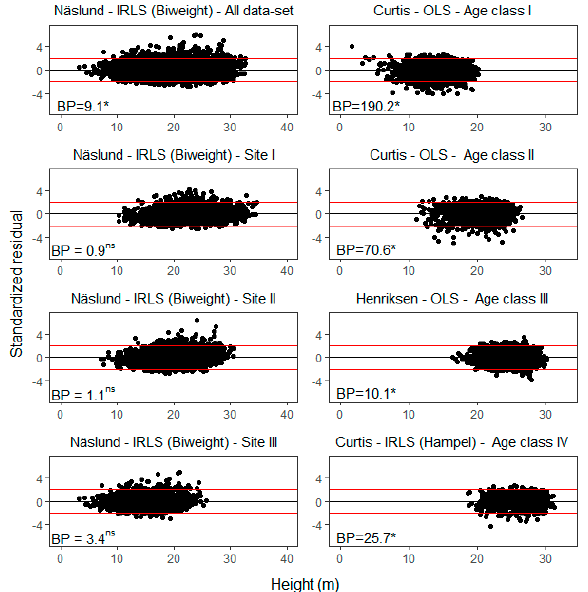
Figure 7. Standardized residual plot for the most representative models fitted by site-index and age classes for Ochroma pyramidale (balsa-tree) stands in Ecuador. BP: Breusch–Pagan’s test value. * is statistically significant at p < 0.05, ns is not statistically significant at p < 0.05.